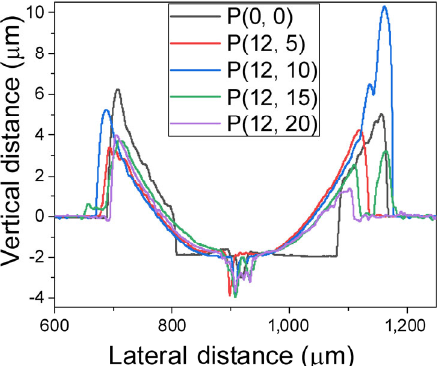
Fig. 12 Surface topography profiles of the wear tracks after the durability test on the PDA/PTFE coatings on smooth and laser textured stainless steel substrates.